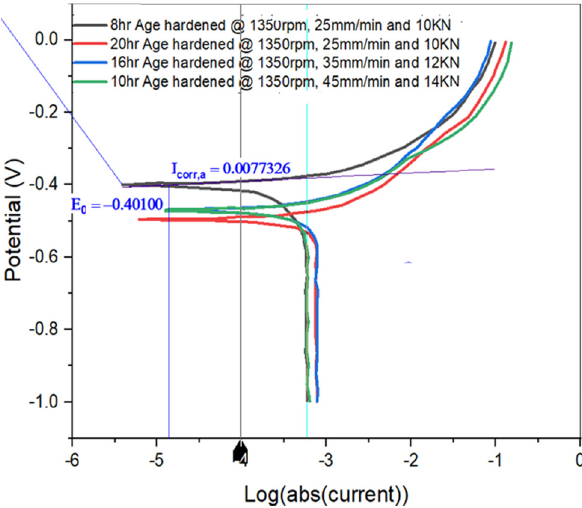
Figure 12: Tafel plot for AH 9 , AH 10 , AH 11 , and AH 12 samples.